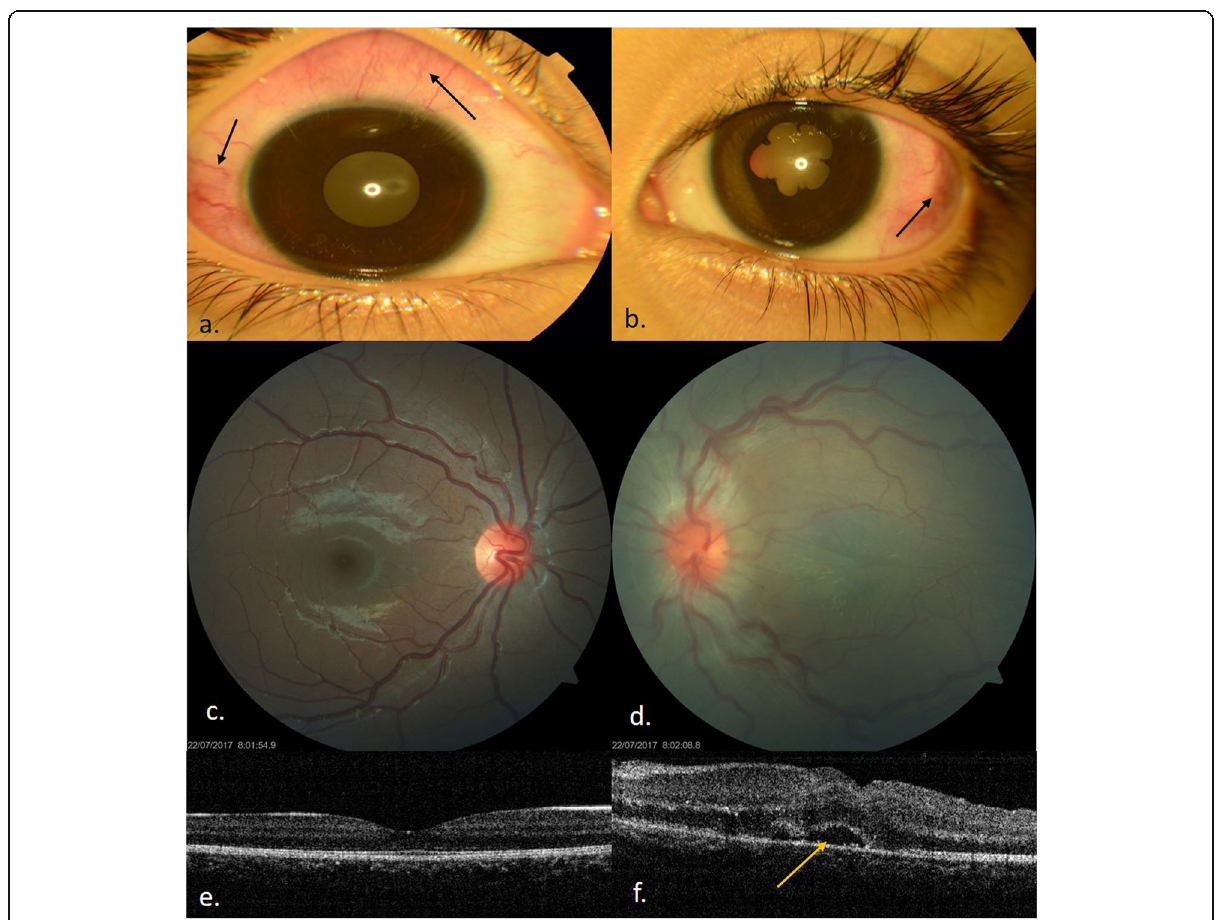
Fig. 1 At presentation. a , b Anterior segment photo of both eyes showing acute nodular anterior scleritis (shown as arrow marks) with posterior synechiae in left eye. c Fundus photograph of right eye showing normal fundus. d Fundus photograph of left eye showing disc edema with retinal striae and tortous vessels. e , f OCT of both eyes. Normal in right eye whereas neurosensory detachment with thickening of inner retinal layers in left